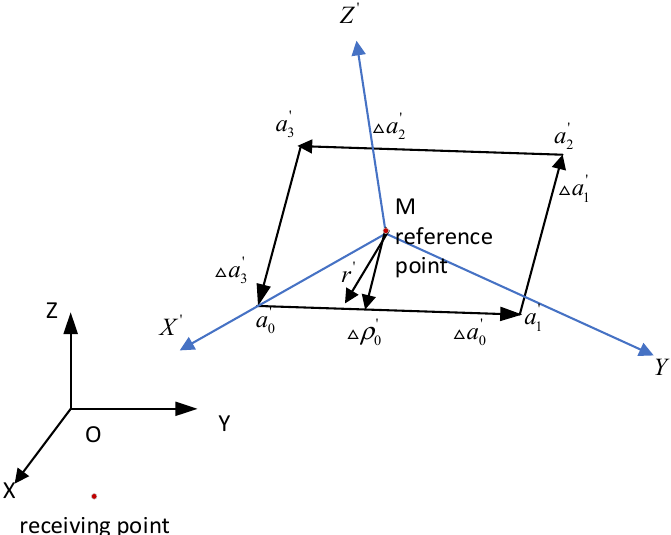
Figure 3. The space vector illustration during target intensity calculation.